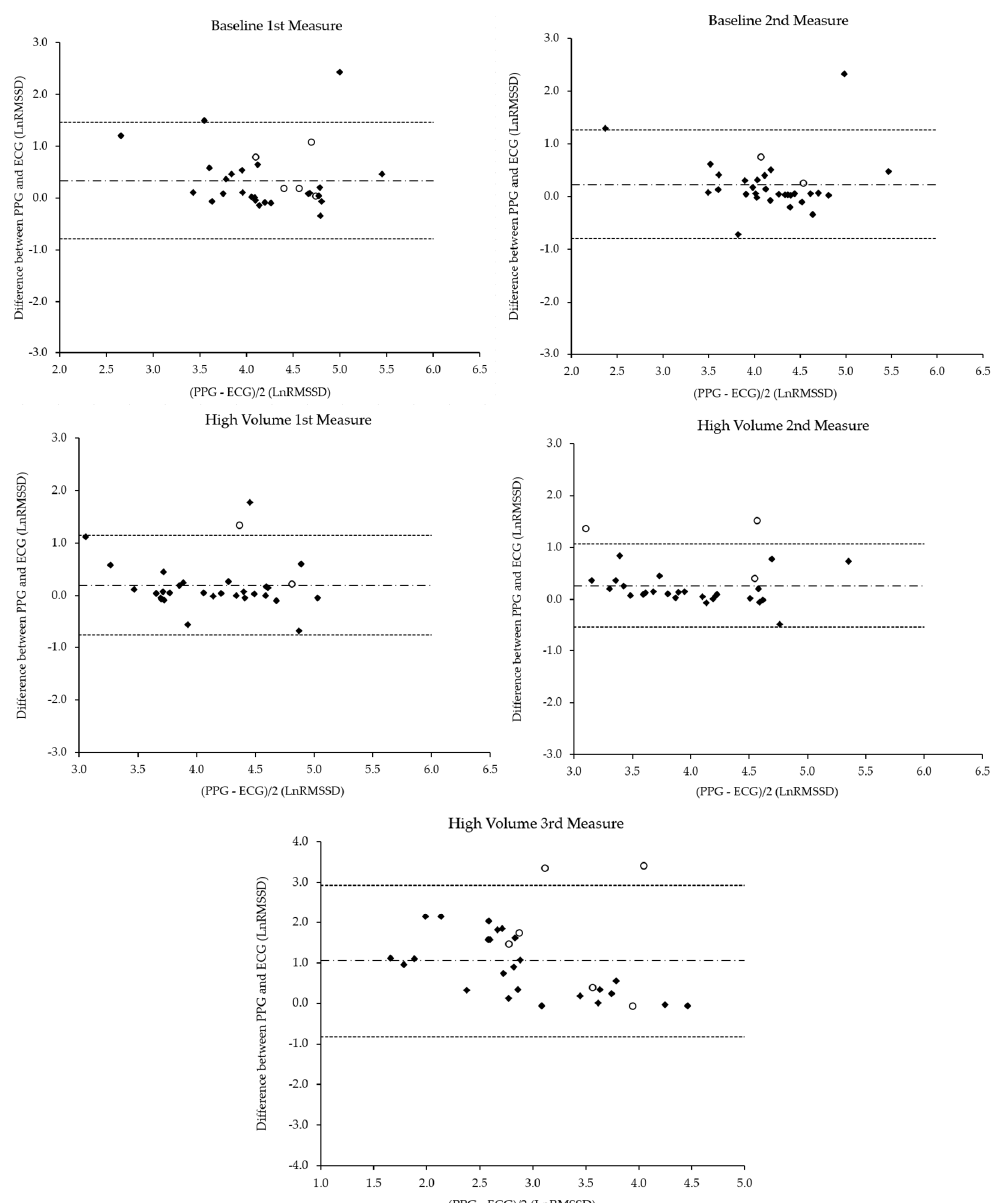
Figure 1. Bland–Altman plots comparing the log transformation of the root mean square of successive RR differences (LnRMSSD) values from the smartphone application photoplethysmography (PPG) with the criterion electrocardiogram (ECG). The solid lines represent the mean bias, whereas the outside dashed lines represent the 95% limits of agreement. Black diamonds represent “optimal” and “good” signal quality measures, and white circles represent “failed” signal quality.